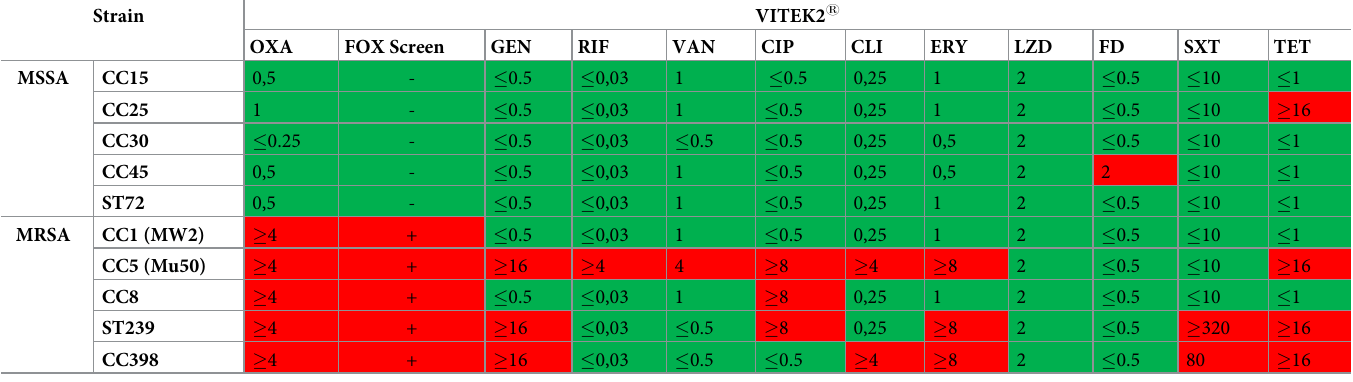
Table 3. The results of VITEK2 1 system for all strains toward tested